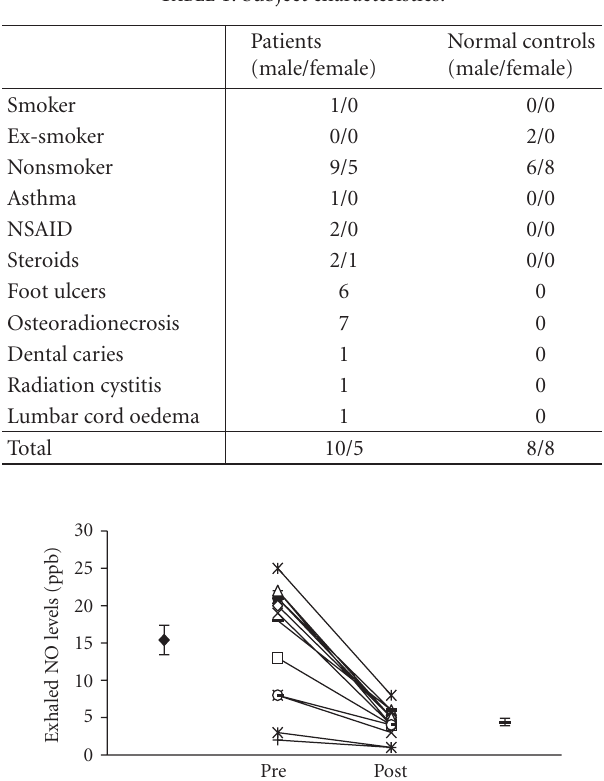
Table 1: Subject characteristics.